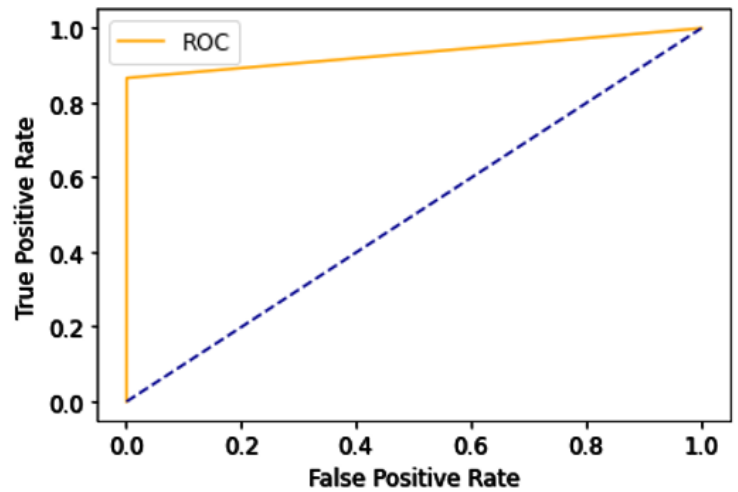
Figure 8. Receiver Operating Characteristic curve of the K-means model trained with data generated by GANs.